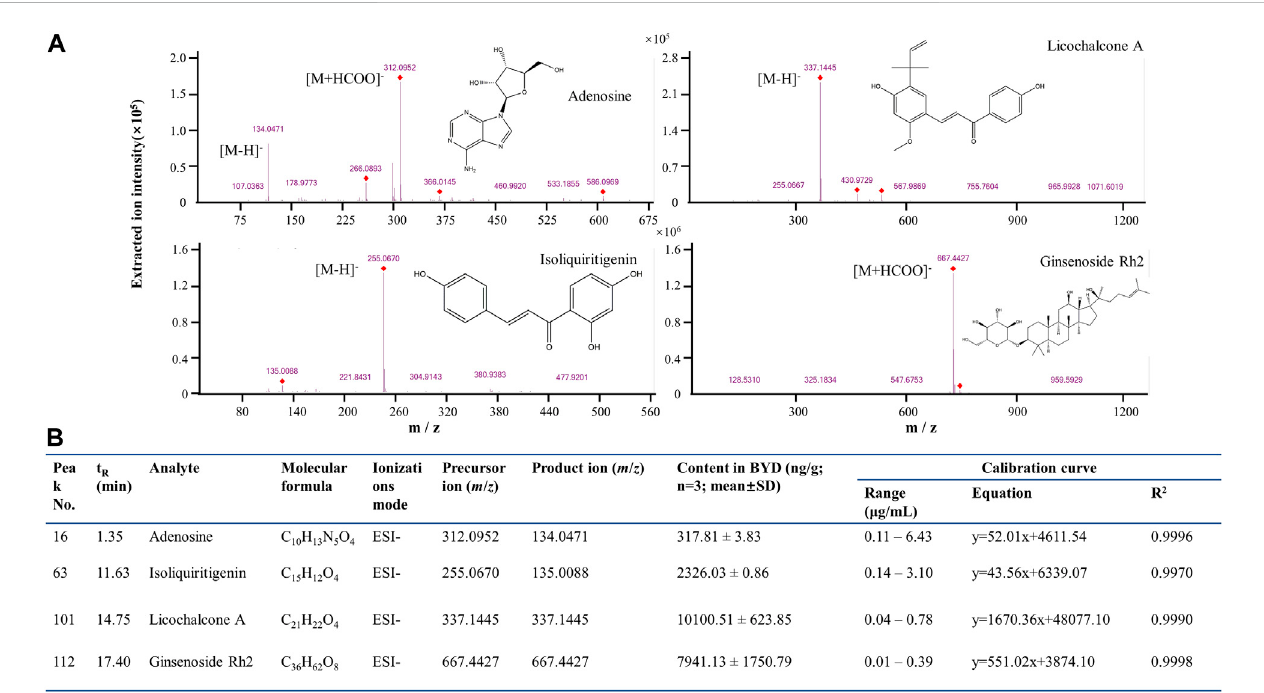
FIGURE 6 UPLC-QTOF-MS/MS quanti fi cation of the active compounds in BYDE. (A) UPLC-QTOF-MS/MS analysis of four standard compounds: The compounds weredetectedbyESIatnegativeion mode. (B) MRMquanti fi cationresultsoffourcompoundsinBYDE.FourcompoundsweredetectedbyESIatnegativeion mode and quanti fi ed by MRM method whereas the corresponding standard compounds were used to generate standard